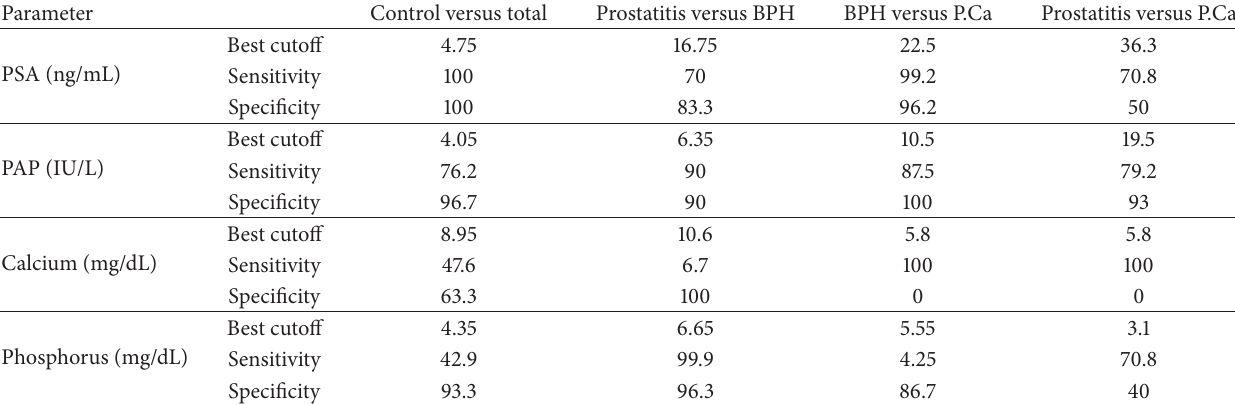
Table 3: The sensitivity and specificity of various biomarkers in different groups are given in the